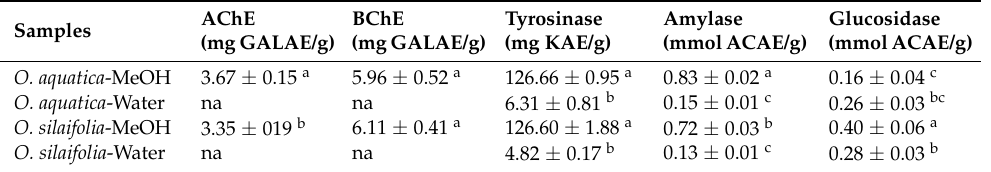
Table 4. Inhibition of selected enzymes exerted by the analyzed extracts.